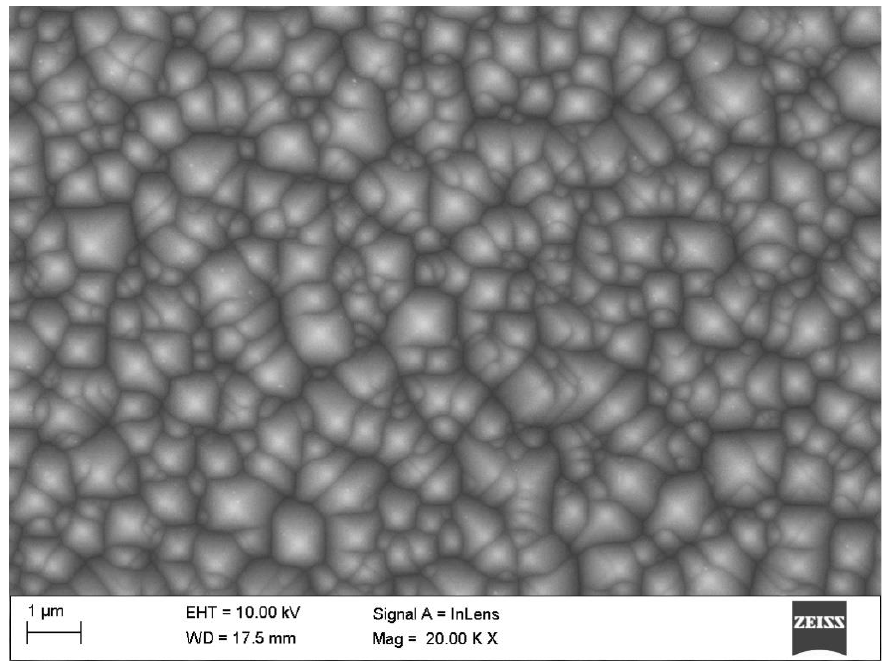
Figure 6. SEM textured surface topography of the N-type monocrystalline silicon solar cell. All leads in the tested N-type solar cells are on the rear surface of the samples (Figure 7). The electrode topography of a monocrystalline silicon photovoltaic cell is shown in Figure 8a,b.